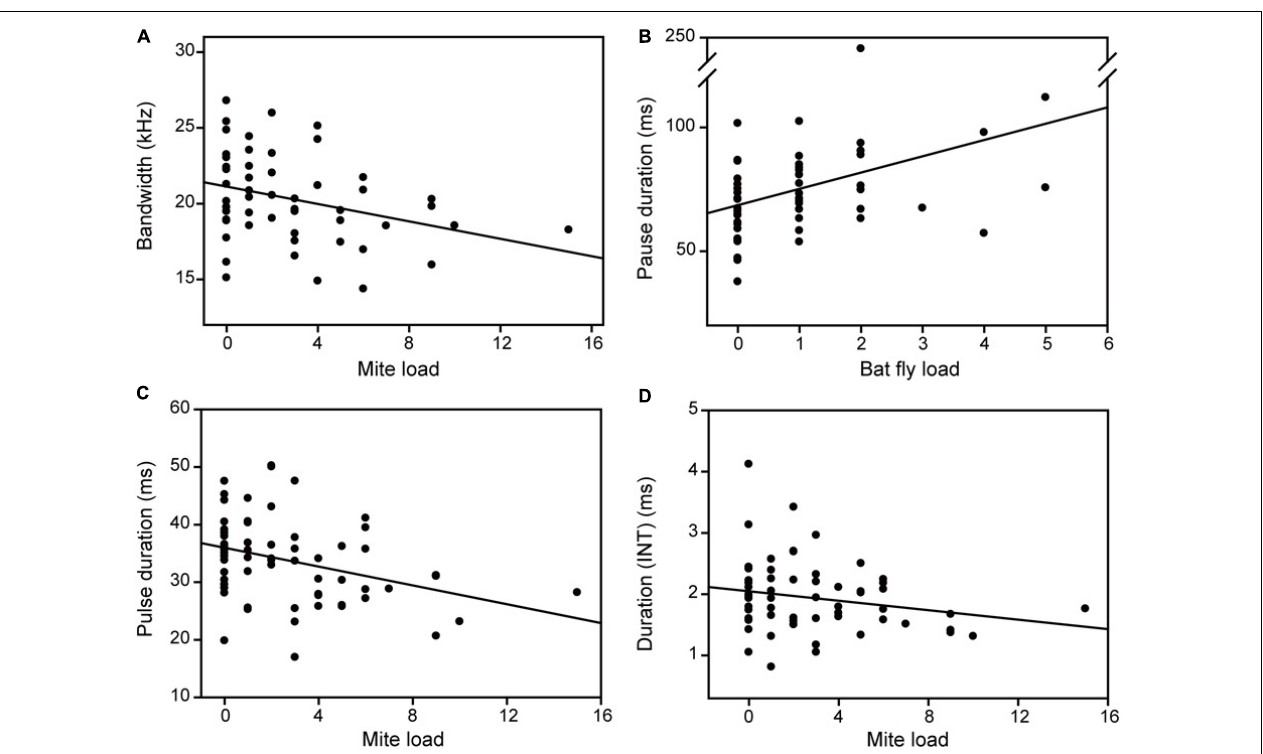
FIGURE 3 | The relationship between parasite load and acoustic parameters of distress calls (A,B) and echolocation pulses (C,D) . INT, initial frequency modulated